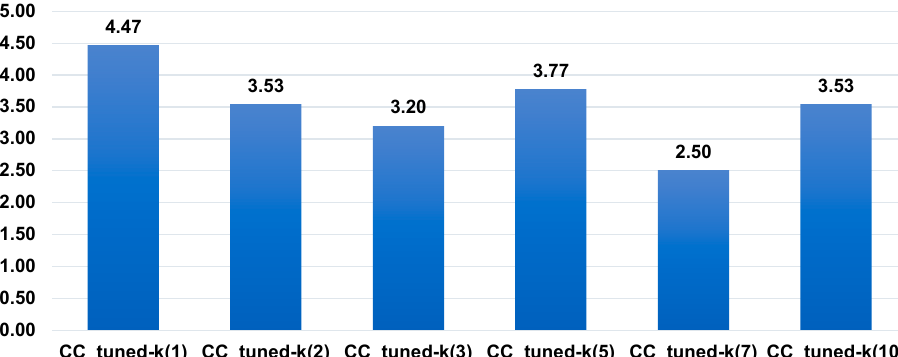
Figure 6. The ranking of CC-tuned-k algorithms.